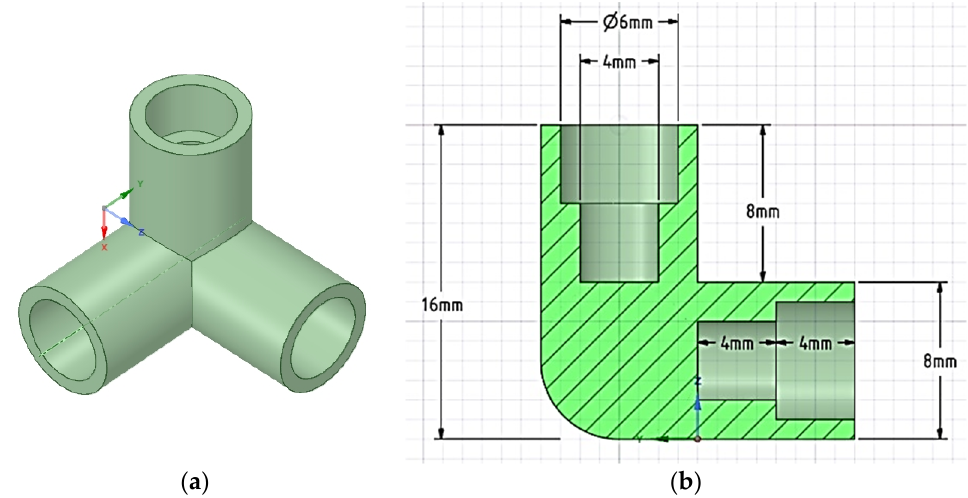
Figure 1. Computer drawing of the connector ( a ) and its dimensions ( b ). alloy (Ti, 5.72%Al, 4.1%V, 0.37%Fe, 0.065%C, 0.04%N, 0.15%O, 0.013%H, by weight),